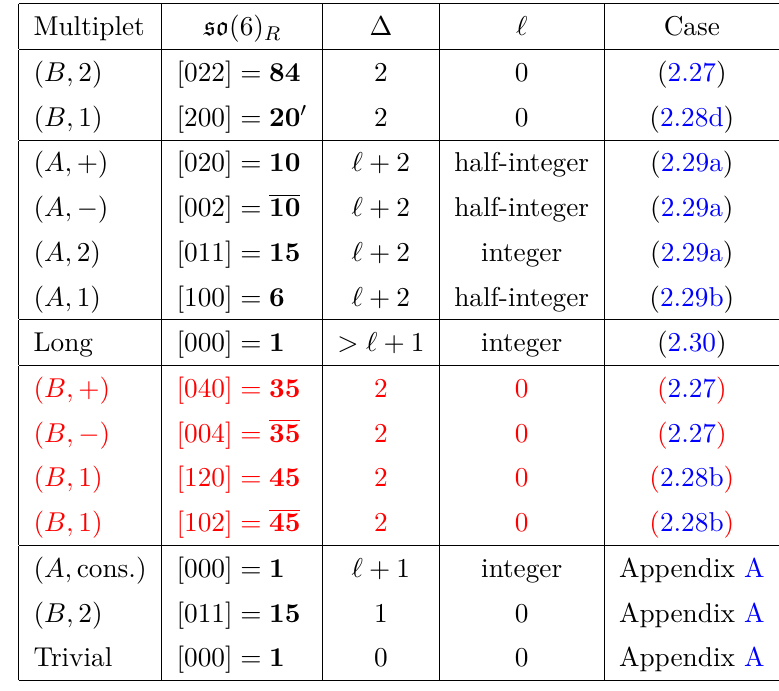
Table 3 . Table of superconformal blocks not eliminated by our analysis. The so (6) R , ∆ and ‘ given the R-symmetry, conformal dimension and spin of the superconformal primary of the exchanged multiplet. The rows in red are for multiplets which we do not eliminate, but for which the super- conformal Casimir equation cannot be solved and so no superconformal block